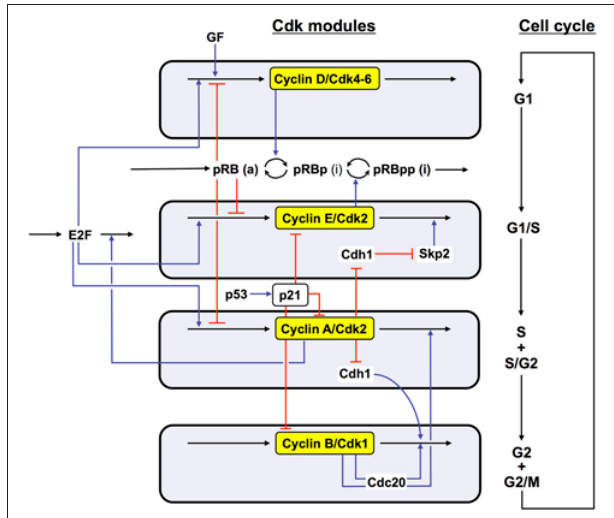
FIGURE 1 | Detailed model for the Cdk network driving the mammalian cell cycle. The model incorporates four modules centered on the main cyclin/Cdk complexes: cyclin D/Cdk4–6, cyclin E/Cdk2, cyclin A/Cdk2, and cyclin B/Cdk1. Also considered are the effect of the growth factor GF and the roles of pRB and E2F, which exert antagonistic controls on cell cycle progression. Cyclin D/Cdk4–6 and cyclin E/Cdk2 control progression in G1 and the G1/S transition by phosphorylating, and thereby inhibiting, pRB. The rise in cyclin A/Cdk2 permits progression in S and G2, while the peak of cyclin B/Cdk1 brings about the G2/M transition. The active, unphosphorylated form of pRB inhibits E2F, which promotes cell cycle progression by inducing the synthesis of cyclins D, E, and A. The protein Cdh1, inhibited by cyclin A/Cdk2, promotes the degradation of cyclin B, and inhibits Skp2, which promotes the degradation of cyclin E; activation of cyclin A/Cdk2 thus leads to the activation of cyclin B/Cdk1 and to the inhibition of cyclin E/Cdk2. The protein Cdc20, activated by cyclin B/Cdk1, promotes the degradation of cyclin A and cyclin B, which leads to the decrease in cyclin A/Cdk2 and cyclin B/Cdk1. For the sake of clarity, not all regulations considered in the model are shown in this scheme—see supporting information in Gérard and Goldbeter (2009) for more detailed schemes of the model for the Cdk network. The combined effects of the regulatory interactions between the four Cdk modules give rise to sustained Cdk oscillations (see Figure 2 ) that allow the cell to progress in a repetitive, oscillatory manner along the successive phases of the cell cycle depicted on the right part of the figure (Gérard and Goldbeter,